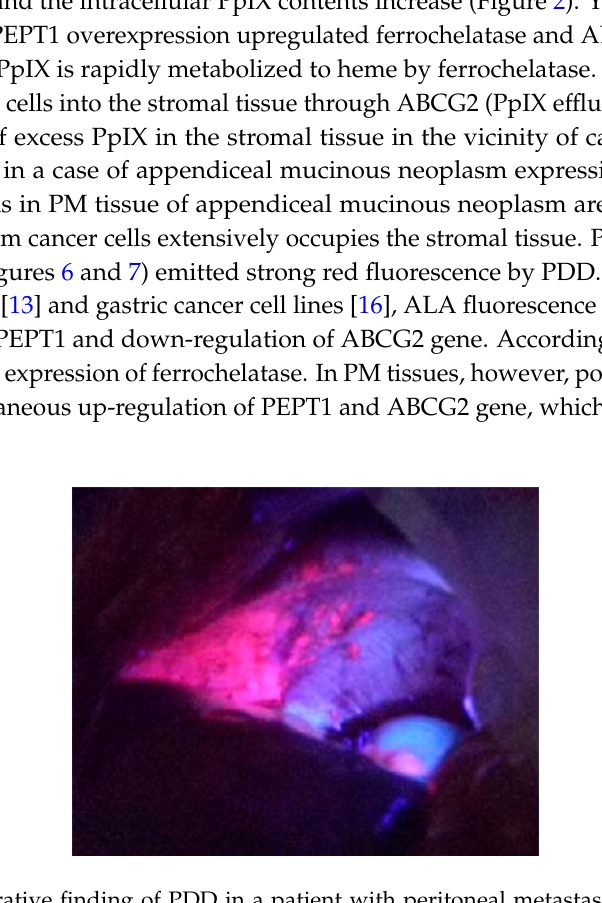
Figure 6. Intraoperative finding of PDD in a patient with peritoneal metastasis from appendiceal mucinous neoplasm on right subdiaphragmatic peritoneum. Peritoneal metastasis with mucinous materials were emitted with red fluorescence by violet right.